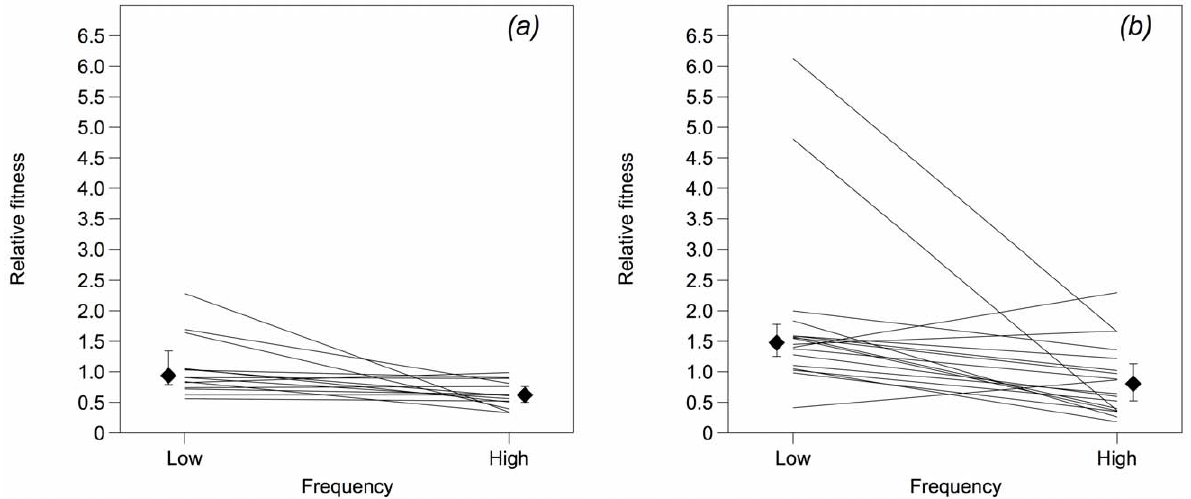
Figure 1. Relative fitnesses of cheat clones derived from the wild type (panel (a), n=14) and mutator (panel (b), n=18) populations described in [ 16 ] . Fitness was measured in competition with cooperating bacteria at initially low (c.5%) and high (c.50%) cheat frequency. Diamonds show medians and associated 95% confidence intervals.